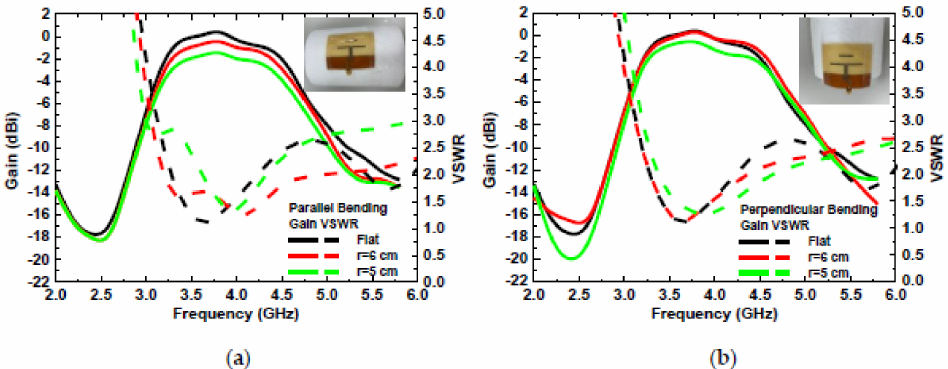
Figure 15. Measured input VSWR and gain of the antenna for ( a ) parallel and ( b ) perpendicular bending with dipole.